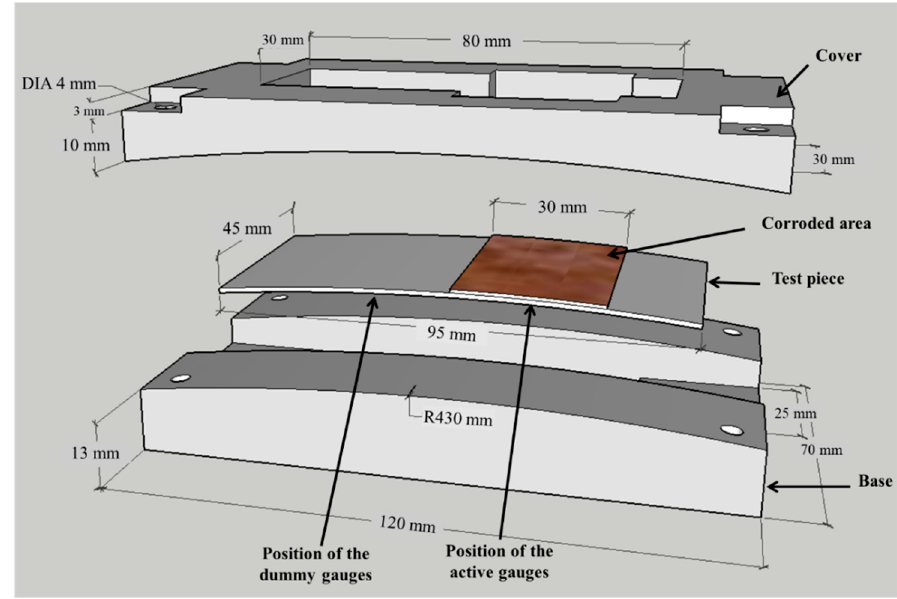
Figure 3. Test piece and apparatus for atmospheric corrosion sensor using strain measurements (ACSSM). The test piece is inserted in the apparatus, which consists of a base and cover with the corroded area measuring 45 mm in length and 30 mm in width.